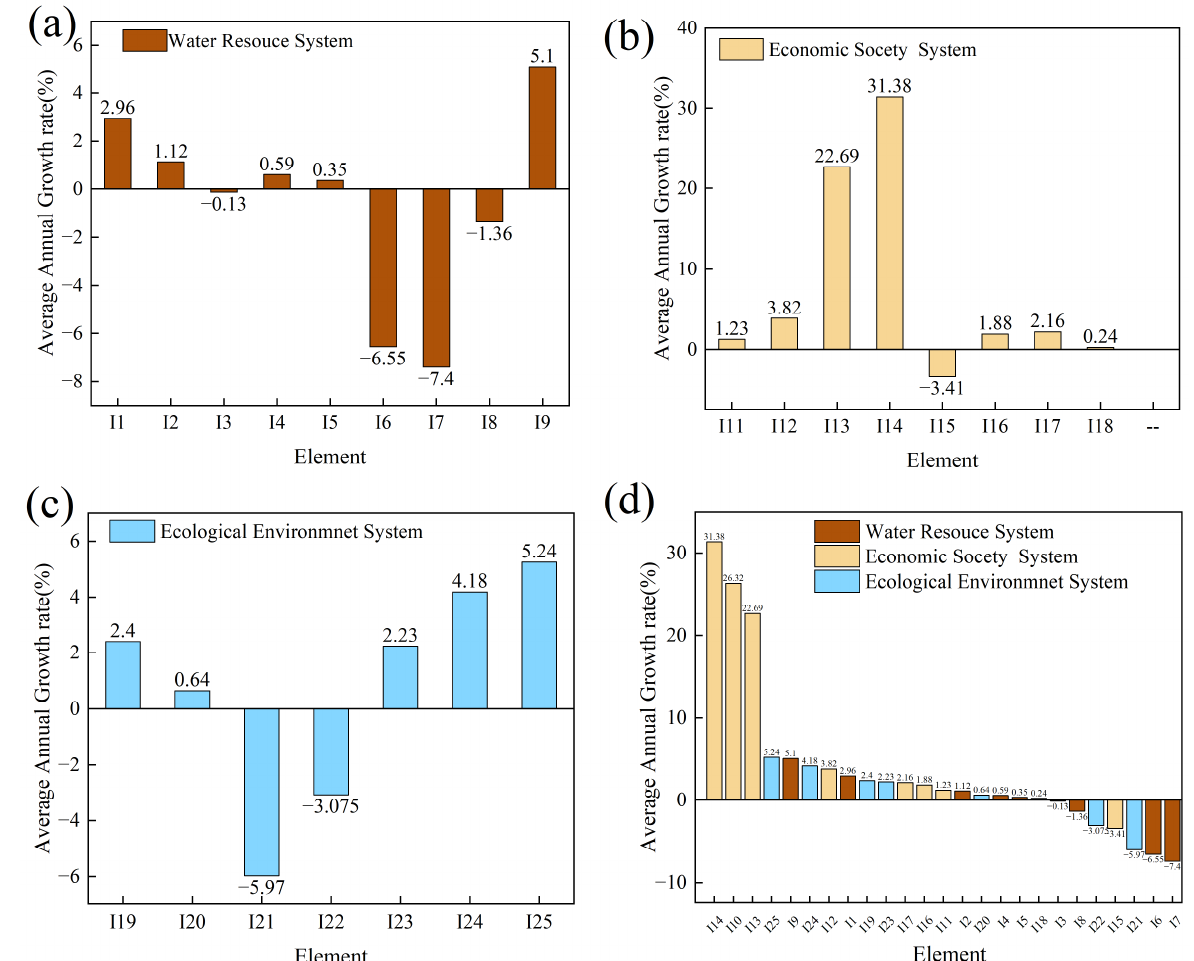
Figure 8. Average annual growth rate of each subsystem element. ( a – c ): the average annual growth rate of three subsystems. ( d ): ranking of average annual growth rate of three subsystems.